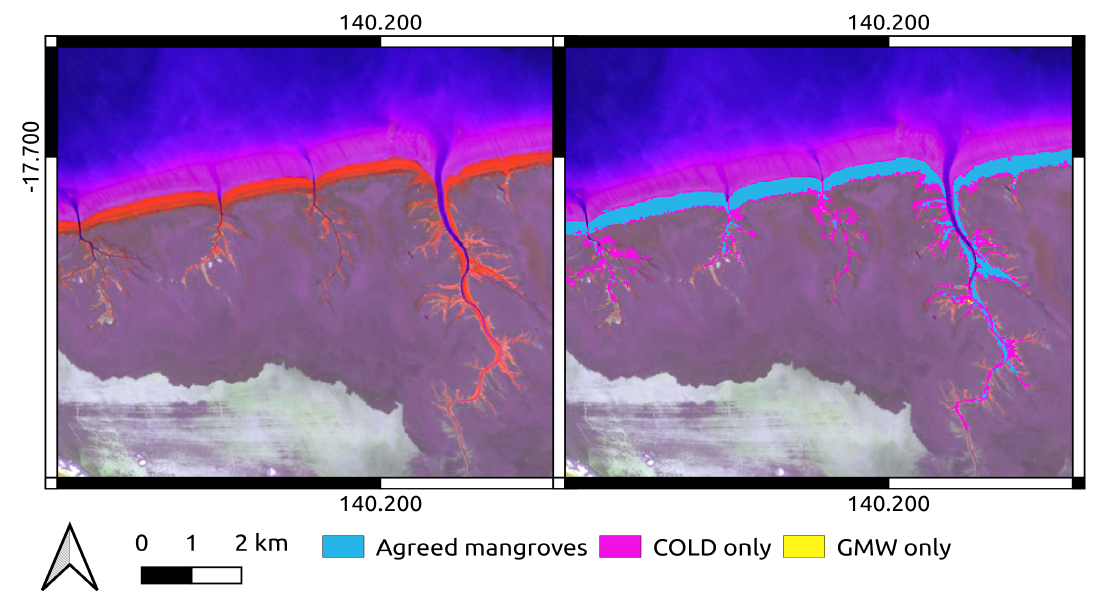
Figure 12. Example classification of mangroves in the Gulf of Carpentaria, North Australia. Left: false colour Landsat 5 image from November 2010 where Red = NIR, Green = SWIR1, and Blue = Red. Right: mangrove classification showing areas of mangroves along the coast which were missed by the GMW but captured by COLD.